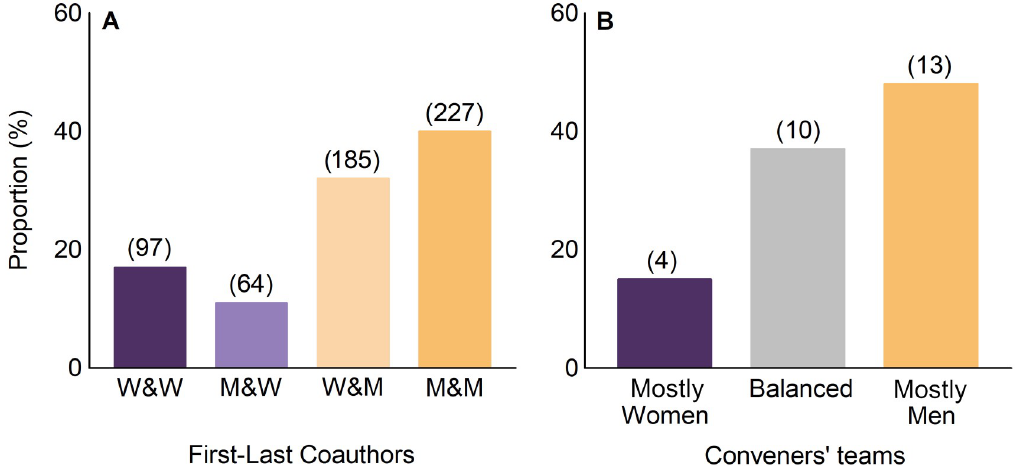
Fig 2. Gender distribution of coauthors and conveners. ( A ) Gender combination of researchers that signed as first and last coauthors in the contributions of the 1 st SIBECOL Meeting (gender first author & gender last author; W = woman and M = man). We interpreted that the first author was the leader of the presented work, while the last author was the principal investigator of the research group or project. ( B ) Proportion of sessions whose conveners were mostly women (purple bar; > 60% of the conveners were women), equally distributed (grey bar; 40–60% of conveners were women), and mostly men (yellow bar; > 60% of conveners were men). The number of contributions (panel A) or sessions (panel B) falling within each category is shown in